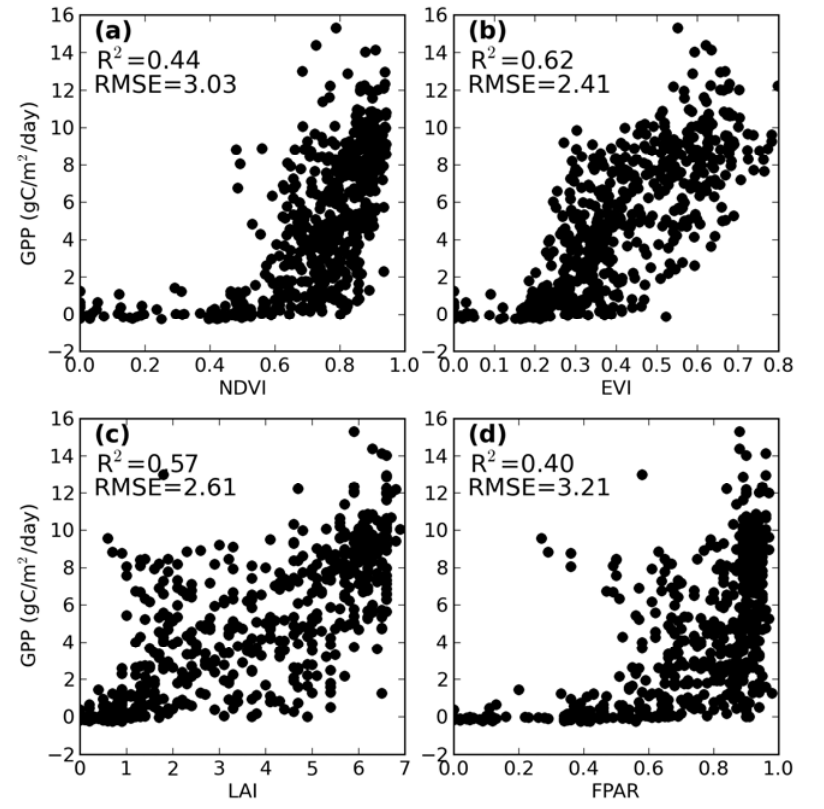
Figure 3. Scatterplot of 32-day composites of GPP vs. ( a ) Normalized Difference Vegetation Index (NDVI), ( b ) Enhanced Vegetation Index (EVI), ( c ) Leaf Area Index (LAI), and ( d ) Fraction of Photosynthetically Active Radiation (FPAR) using data from all the sites.